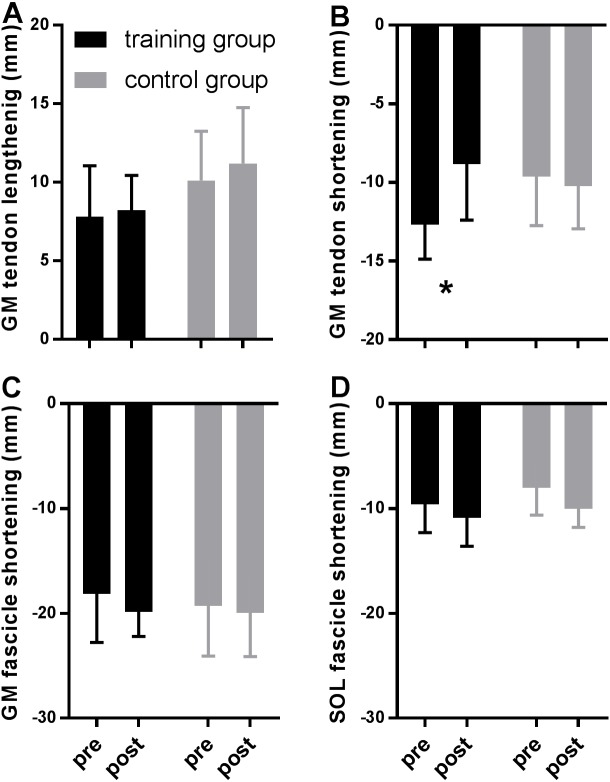
Tendon (A–B) and fascicle (C–D) measures during the stance phase of running compared between tests pre- and post-training in the training (black) and the control group (grey).Data are means ± s.d., * P < 0.05 when comparing pre vs. post intervention.